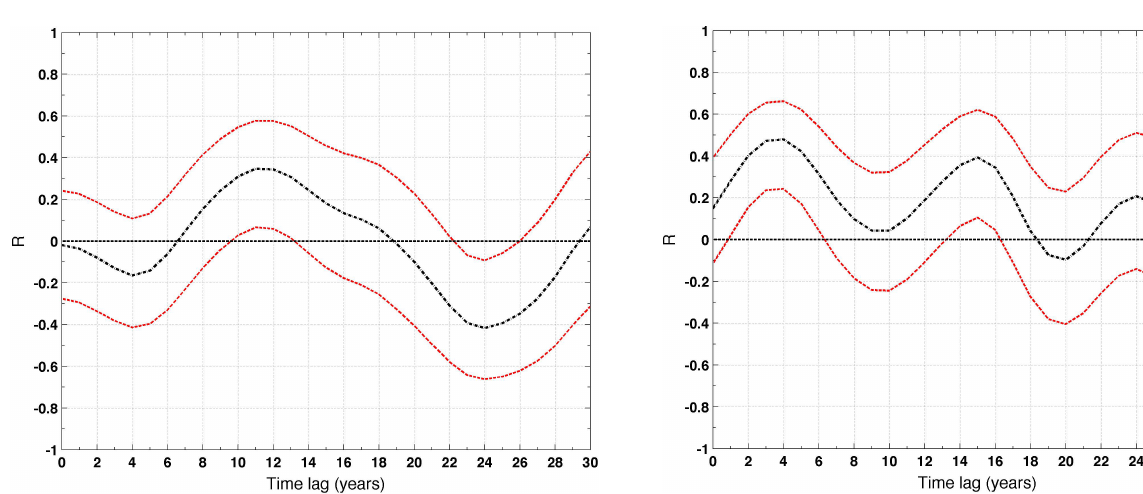
Fig. 4. Moving correlation between the Sicily Channel and Levan- tine Sea spatially averaged salinity data (for the averaging area see the Fig. 1). Dashed lines represent 95% confidence interval around the correlation curve.